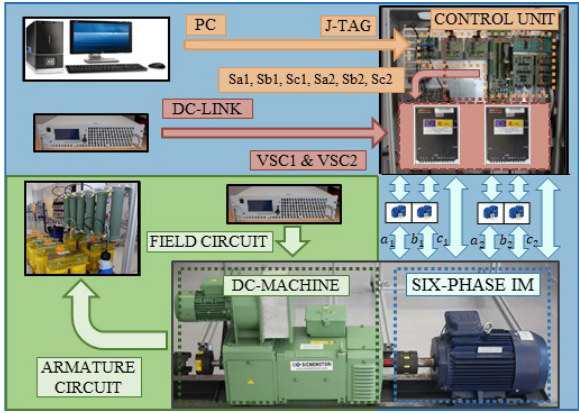
Figure 7. Experimental test